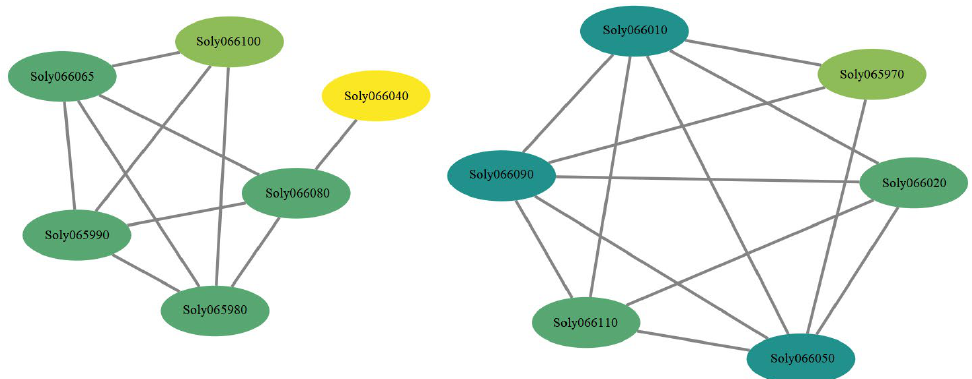
Figure 5. Interaction network of genes within 50 kb upstream and downstream of TGS0892 in tomato. The circles represent genes, the straight lines represent the regulatory relationship between genes. The color of the circles represents the degree value, that is, the number of relationships between a gene in the network and its surrounding genes.